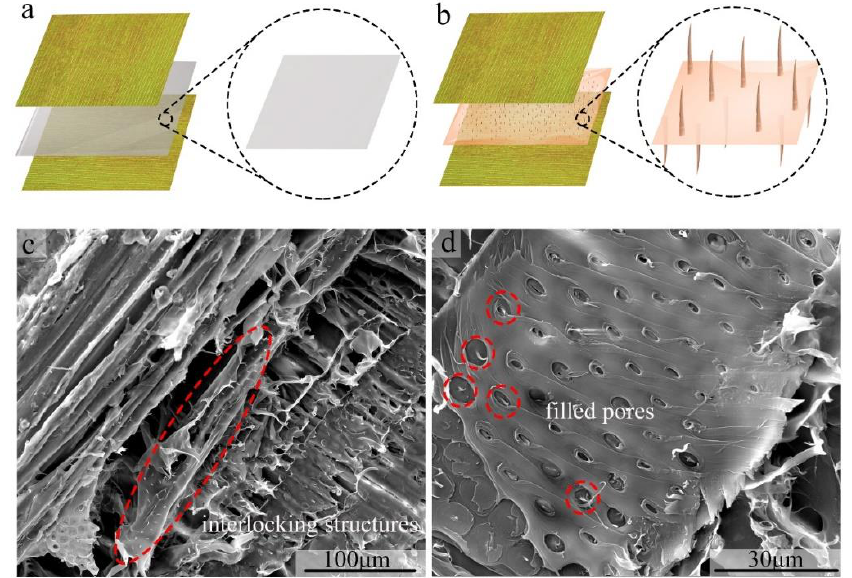
Figure 6. Models for the internal structure of PVA samples in bonding wood: ( a ) The pure PVA forms flat structures ( b ) ferric ions modified PVA forms interlocking structure; SEM images of ( c ) numerous needle-like interlocking structure formed by filling wood porous structure captured in PVA-2.0% sample; ( d ) the modified PVA filled pores in wood structure.